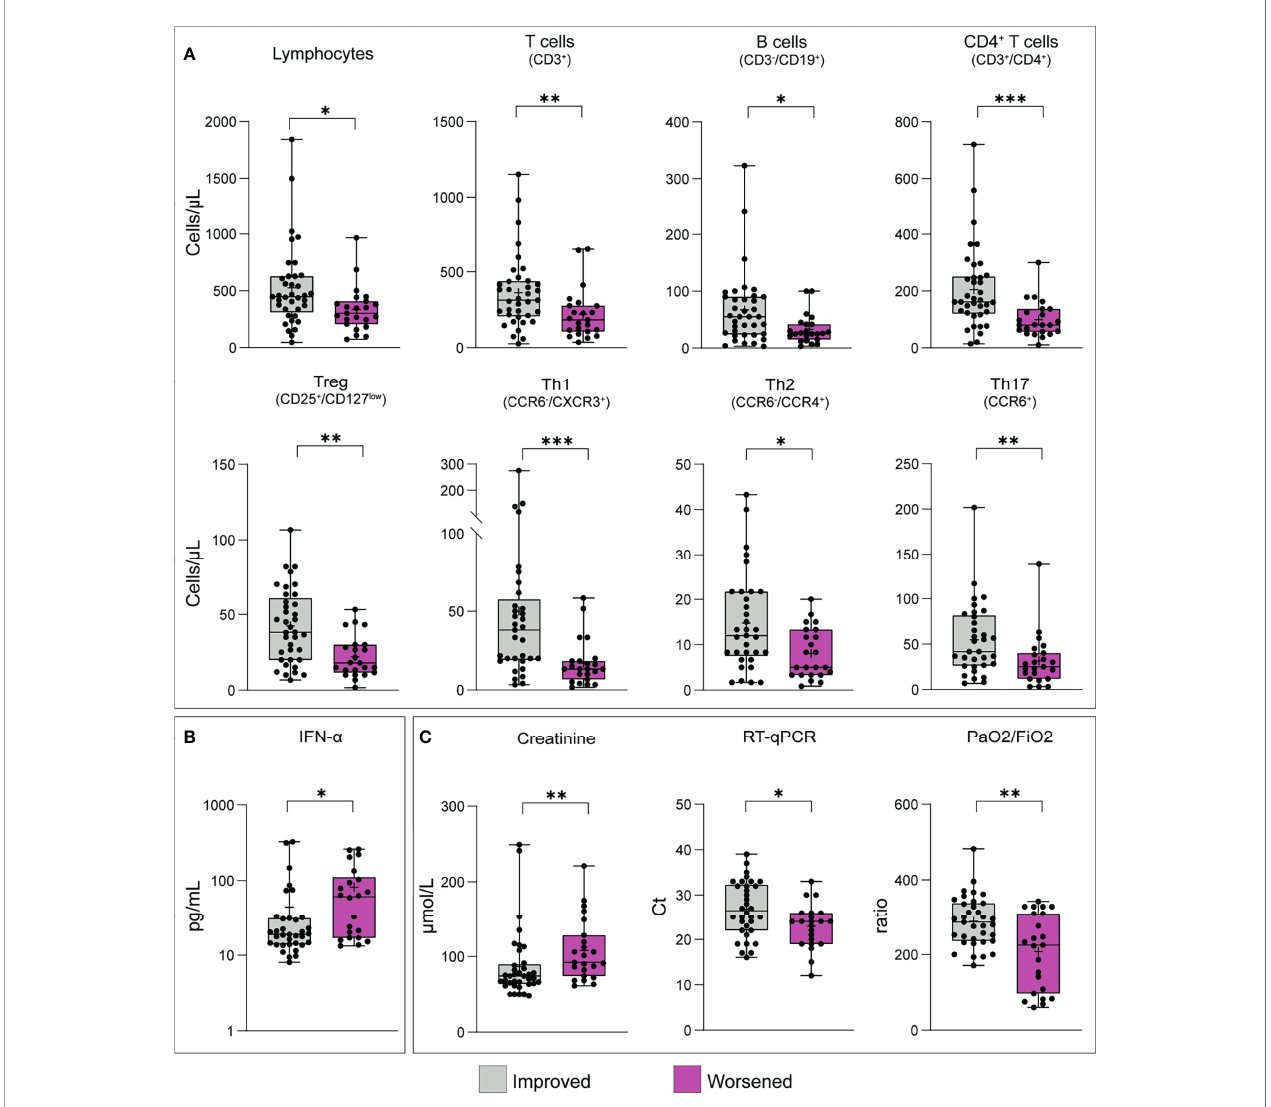
FIGURE 3 | T cell frequencies, cytokine concentrations and laboratory fi ndings in patients classi fi ed according to the clinical course during hospitalisation. Patients were classi fi ed as improved (n = 37) or worsened (n = 23) as reported in the methods section. (A) T cell and T cell subset frequencies; (B) cytokine concentration; (C) laboratory fi ndings. Only results statistically signi fi cant are reported. Statistical signi fi cance, set at p-value <0.05, was assessed using the Mann-Whitney U test. *p < 0.05; **p < 0.01; ***p < 0.001. Whiskers represent minimum and maximum values, dots represent individual observations, the + on each box indicates the